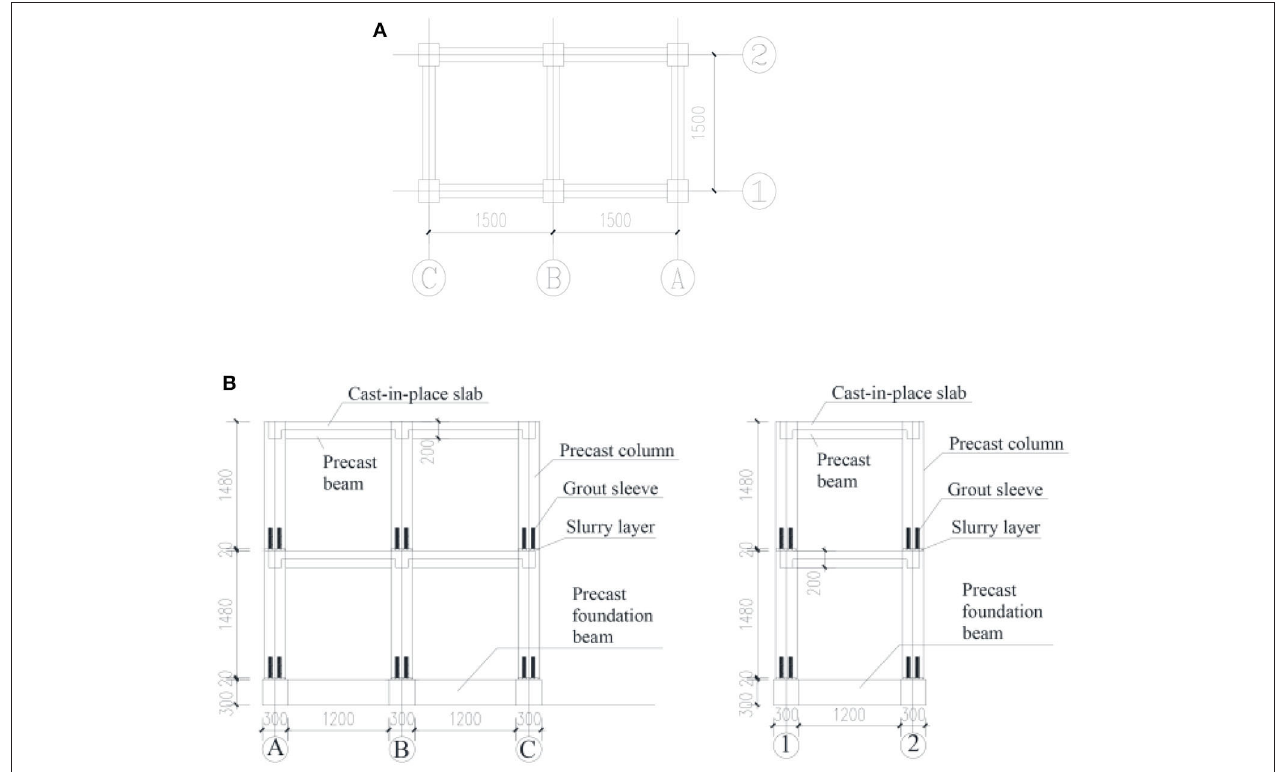
FIGURE 6 | Plan and elevation views of the frame model. (A) Plan view of the column net of the frame model. (B) The A–C and 1–2 elevation views of the frame model.